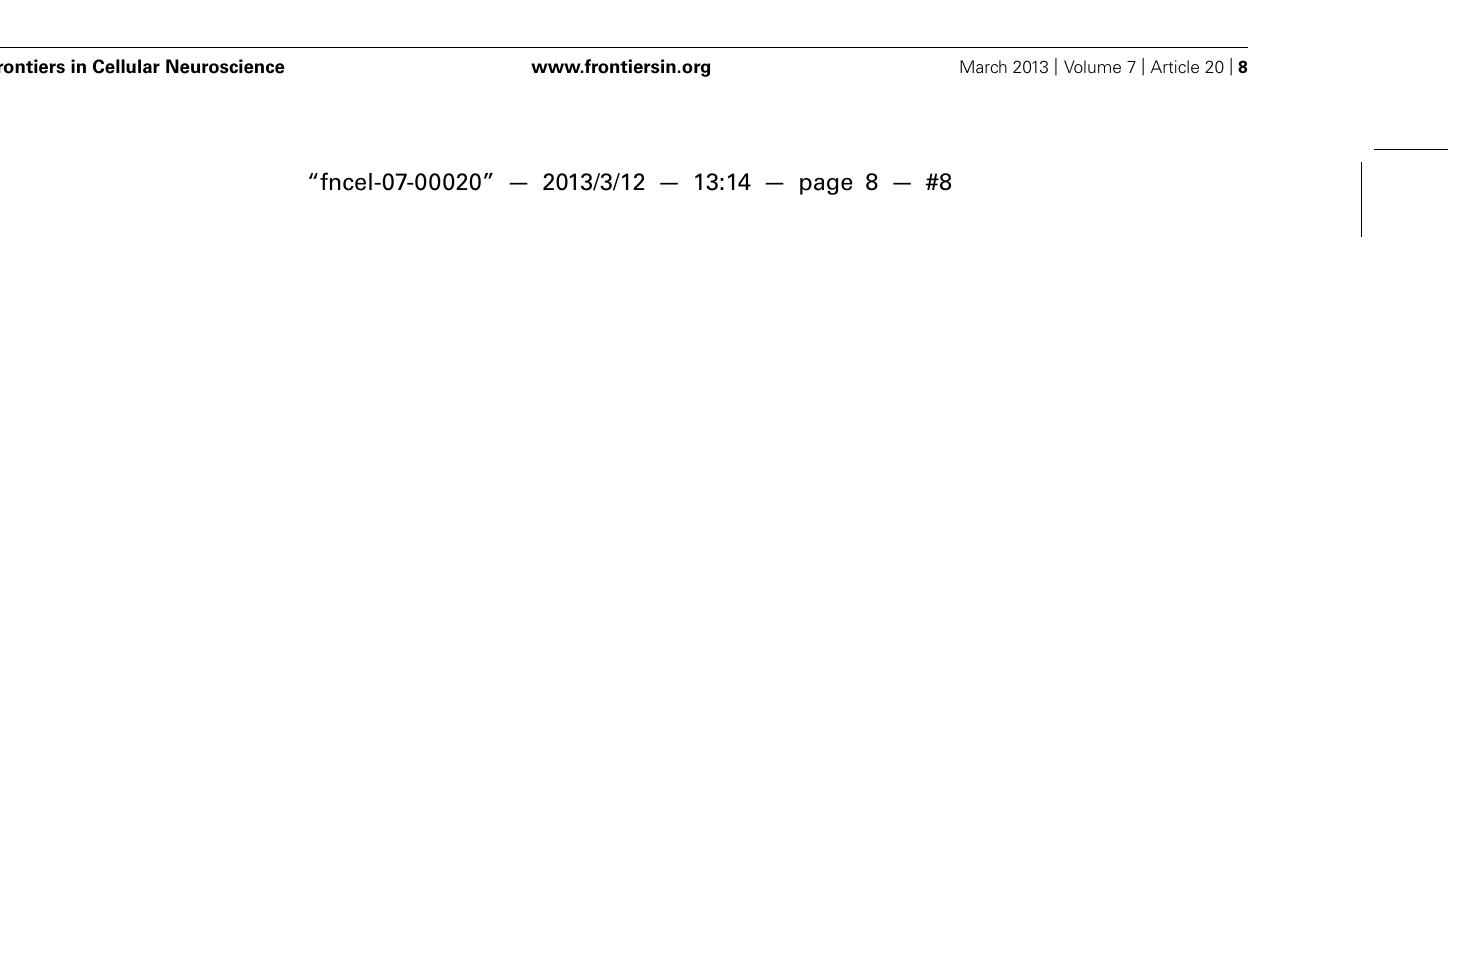
FIGURE 5 | Depth-dependence of isoguvacine effects on MUA in the hippocampal slice at P2–4. Scheme of recording setup is shown on (C) . A 16-channel silicone probe (50 μ m distance between the electrodes) is inserted vertically in the CA3 pyramidal cell layer of 550 μ m-thick slice. Recordings from the electrodes indicated as “depth” and “surface” are shown on (A,B) . (A,B) Extracellular recordings of MUA responses evoked by bath-applied GABA(A) receptor agonist isoguvacine from the surface and